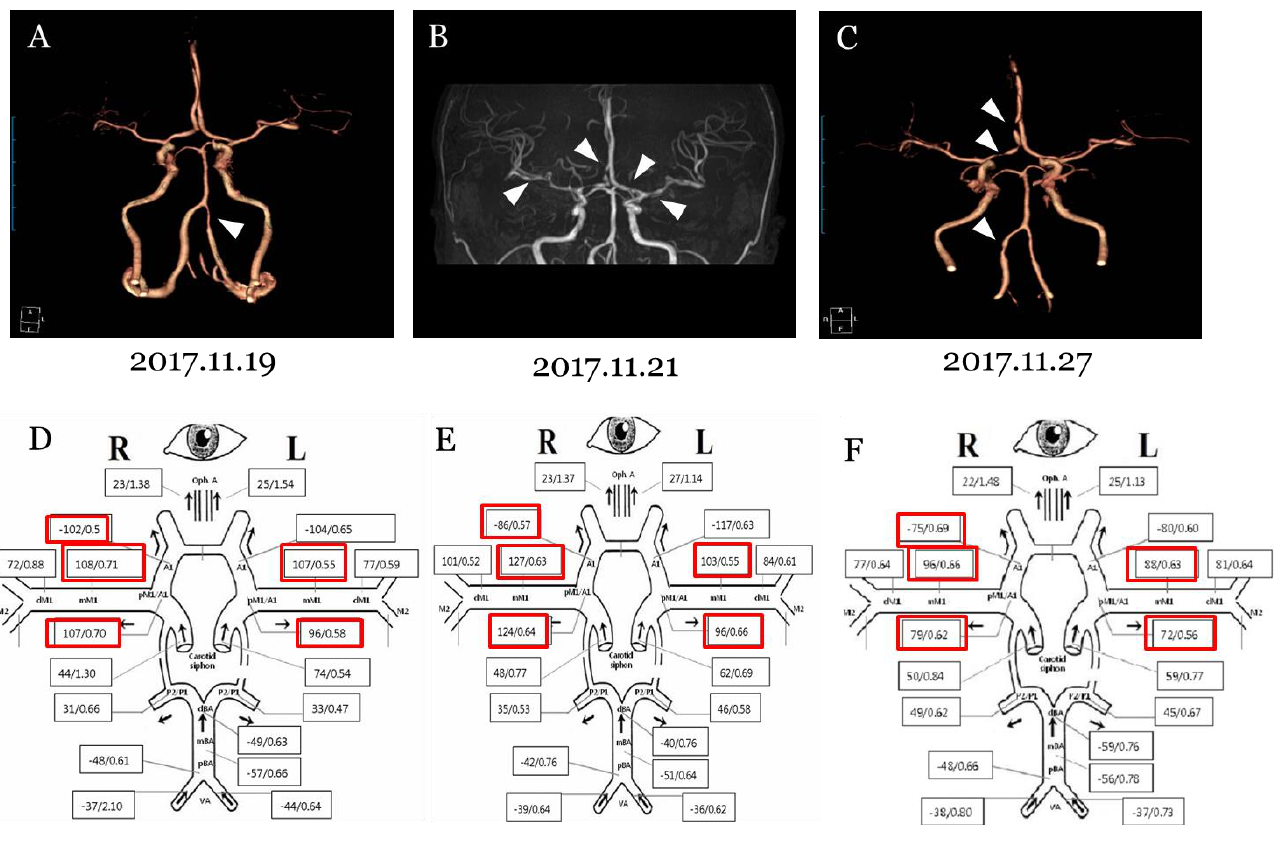
Figure 1. Serial images and TCD findings on patients. ( A ) Computed tomography angiography revealed segmental stenosis of the left vertebra artery (arrow). ( B ) Magnetic resonance angiography showed newly developed multiple arterial stenosis on left A1 segment, right proximal A2 segment of right anterior cerebral artery of, and bilateral middle cerebral arteries (arrows). ( C ) Follow up computed tomography angiography showed arterial stenosis on the right anterior cerebral artery and vertebral artery but the stenosis of both MCAs was improved. ( D ) Initial TCD showed increased MFV of bilateral MCAs and ACAs. ( E ) It was confirmed that the MFV of right MCA and left ACA was worse in the subsequent TCD. ( F ) The last TCD after 1 month showed that MFV of bilateral MCAs and ACAs was improved.